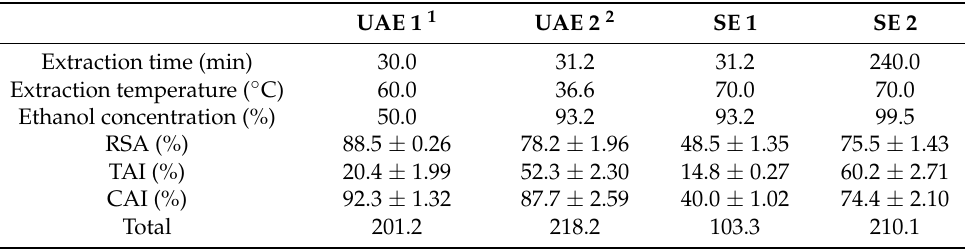
Table 5. Comparison of RSA, TAI, and CAI of peanut shell extract obtained by Soxhlet extraction (SE) and ultrasound-assisted extraction (UAE) at different extraction conditions.